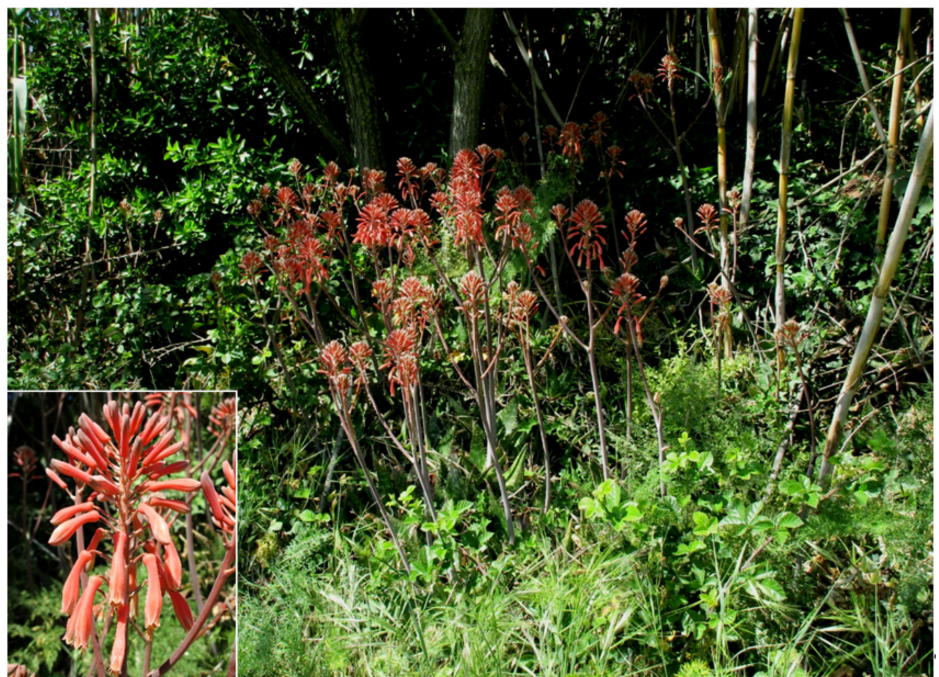
Figure 44. Aloe maculata All. subsp. maculata (Caffarella valley).